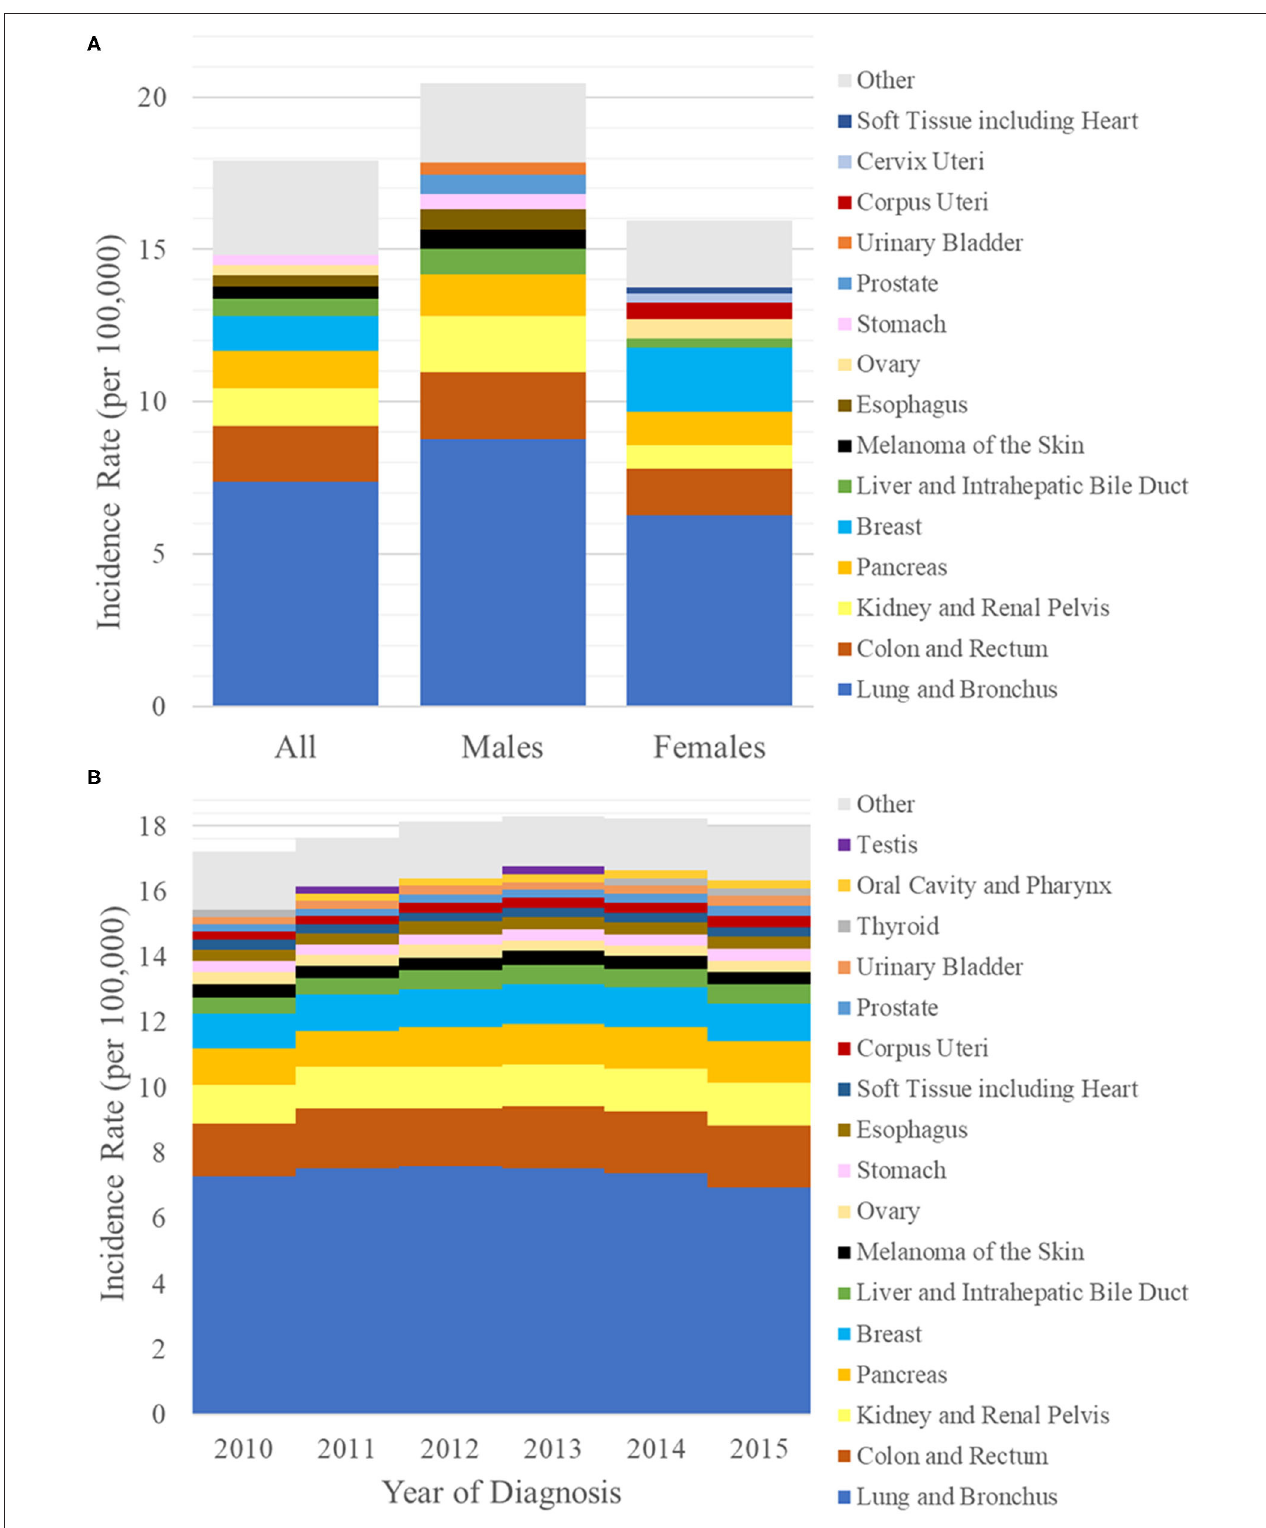
FIGURE 1 | (A) Bar graph of the incidence rates per 100,000 of synchronous lung metastasis (y-axis) from 2010 to 2015 in the general population (left) and in either sex (males: middle, females: right). (B) Bar graph of the incidence rates per 100,000 of synchronous lung metastasis (y-axis) vs. year of diagnosis (x-axis) from 2010 to 2015. Each bar is broken down by primary sites of origin, which are indicated by different colors.